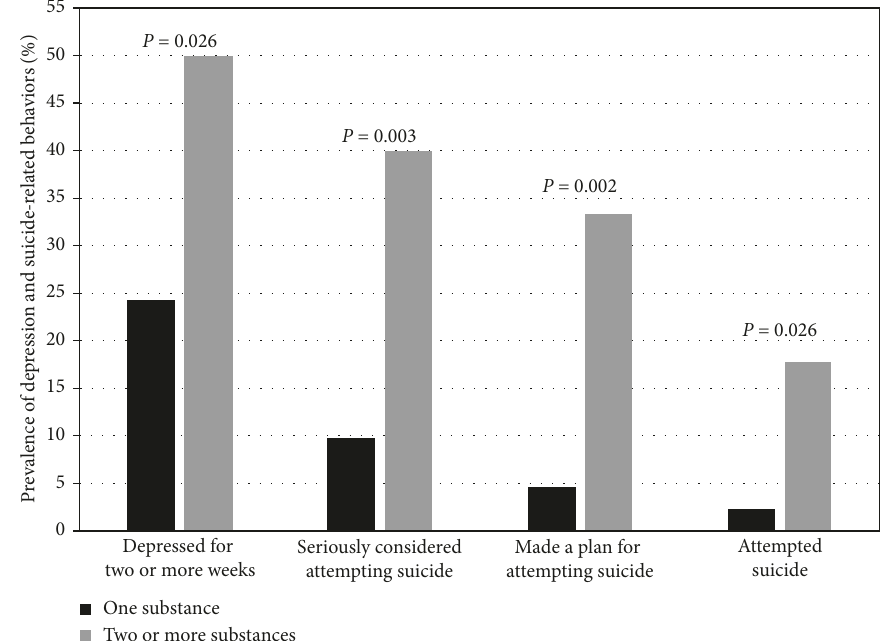
Figure 1: Effect of one vs. multiple risk behaviors (alcohol, smoking, marijuana, and drug use) on the prevalence of depression and suicidal behaviors in adolescents with chronic kidney disease. Values represent the percent of each high-risk behavior group with “yes” responses for depression and suicidal behaviors in the past 12 months. For the high-risk behaviors groups, sample sizes are 41 for one and 30 for two or more for the depression, considered attempting suicide, and made a suicide plan variables. For attempted suicide, sample sizes are 41 for one and 28 for two or